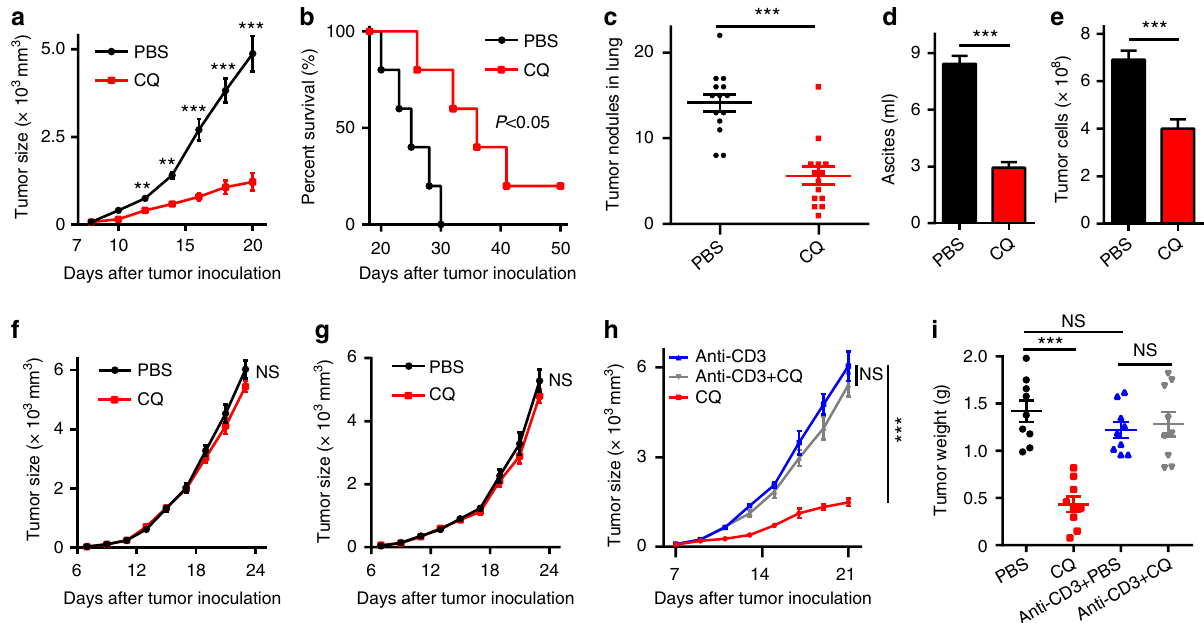
Fig. 1 CQ-mediated antitumor effect is T-cell dependent. a C57BL/6 mice ( n = 6) with subcutaneous B16 melanoma were i.p. treated with PBS or 75mgkg − 1 CQ and the tumor growth was monitored for 2 weeks. b C57BL/6 mice ( n = 10) with subcutaneous B16 melanoma were i.p. treated with PBS or 75mgkg − 1 CQ for 2 weeks. The long-term survival was recorded according to Kaplan – Meier analysis and analyzed by log-rank (Mantel – Cox) test. c C57BL/6 mice ( n = 14) were intravenously injected with 5×10 4 B16 cells. One week later, the mice were peritoneally treated with PBS or 75mgkg − 1 CQ for 2 weeks and then killed for lung tumor nodules determination. d , e BALB/c mice ( n = 6) with H22 hepatocarcinoma ascites were i.p. treated with PBS or 75mgkg − 1 CQ for 1 week and then killed. The tumor ascites volume d and the tumor cell number e were measured. f Nude mice ( n = 12) with B16 melanoma were received daily i.p. injection of PBS or 75mgkg − 1 CQ for 2 weeks. Tumor growth was measured. g Nude mice ( n = 10) with subcutaneous H22 hepatocarcinoma were i.p. injected with PBS or 75mgkg − 1 CQ for 2 weeks. Tumor growth was followed. h C57BL/6 mice ( n = 9) with B16 melanoma were treated with anti-CD3 neutralizing antibody and/ or CQ for 2 weeks. Tumor growth was monitored. i BALB/c mice ( n = 6) with H22 muscle hepatocarcinoma were intratumorally injected with PBS or CQ with or without anti-CD3 neutralizing antibody treatment. After 1 week, the mice were killed and the tumor weight was measured by the weight of right thigh minus the left. Data shown are representative of three independent experiments and error bars represent mean±SEM. * P< 0.05; ** P< 0.01; *** P< 0.001; NS,